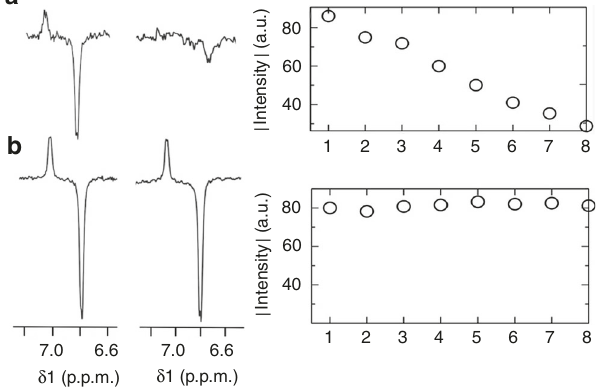
Fig. 4 Photo-CIDNP of AcTyr under continuous illumination. a Array of eight consecutive (not on- fl ow) experiments (28 scans each). Continuous irradiation of the active volume during the whole experiment causes fl avin photodegradation. Left of panel: spectra corresponding to the fi rst (1st) and last (8th) experiments showing the impact of degraded fl avin on the AcTyr CIDNP signal. Right of panel: Plot of the AcTyr CIDNP signal intensity of the eight consecutive experiments. The increasing signal decay occurs due to gradual accumulation of degraded fl avin within the detection volume. b Array of eight consecutive on- fl ow experiments (28 scans each) under continuous illumination. Left of panel: spectra corresponding to the fi rst (1st) and last (8th) experiments showing the bene fi ts of pumping fresh sample on the AcTyr CIDNP signal. Right of panel: Plot of the CIDNP AcTyr signal intensity at the end of each of the eight consecutive